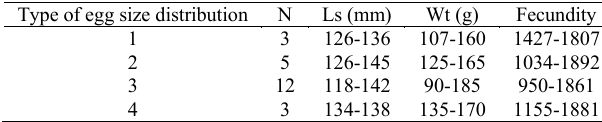
Table 3. Standard length (Ls), total weight (Wt), number (N) and fecundity range for each type of egg size distribution of pre-spawning female of Symphysodon aequifasciatus